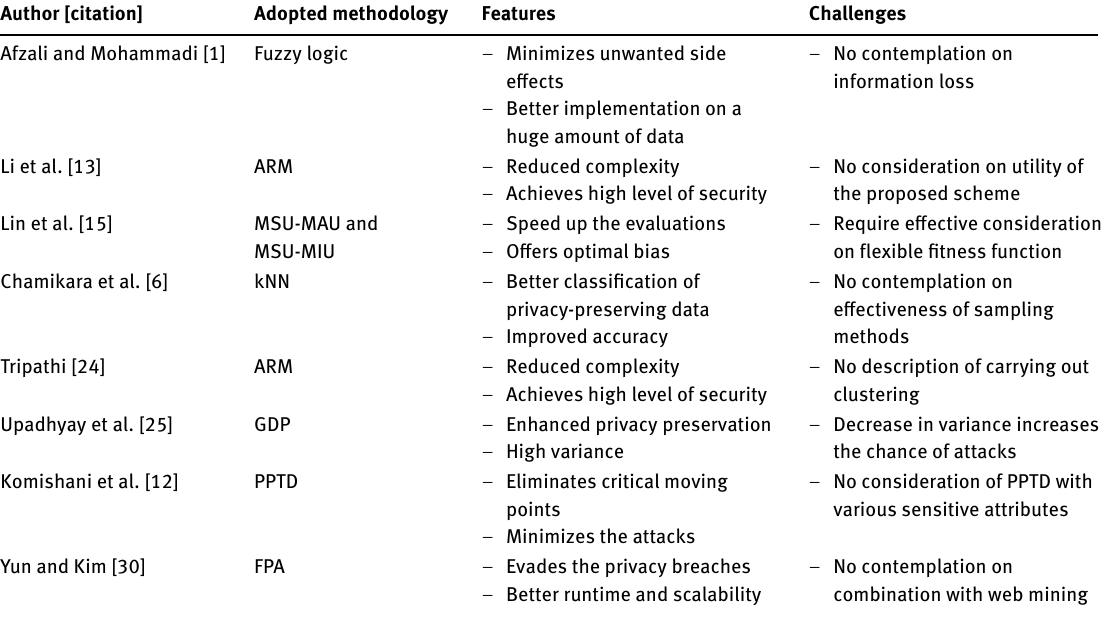
Table 1: Review on State-of-the-Art Privacy Data Preservation